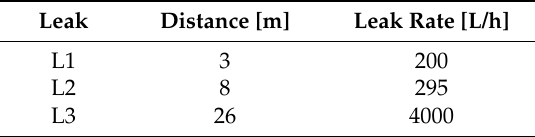
Table 1. Characteristics of the generated leaks.